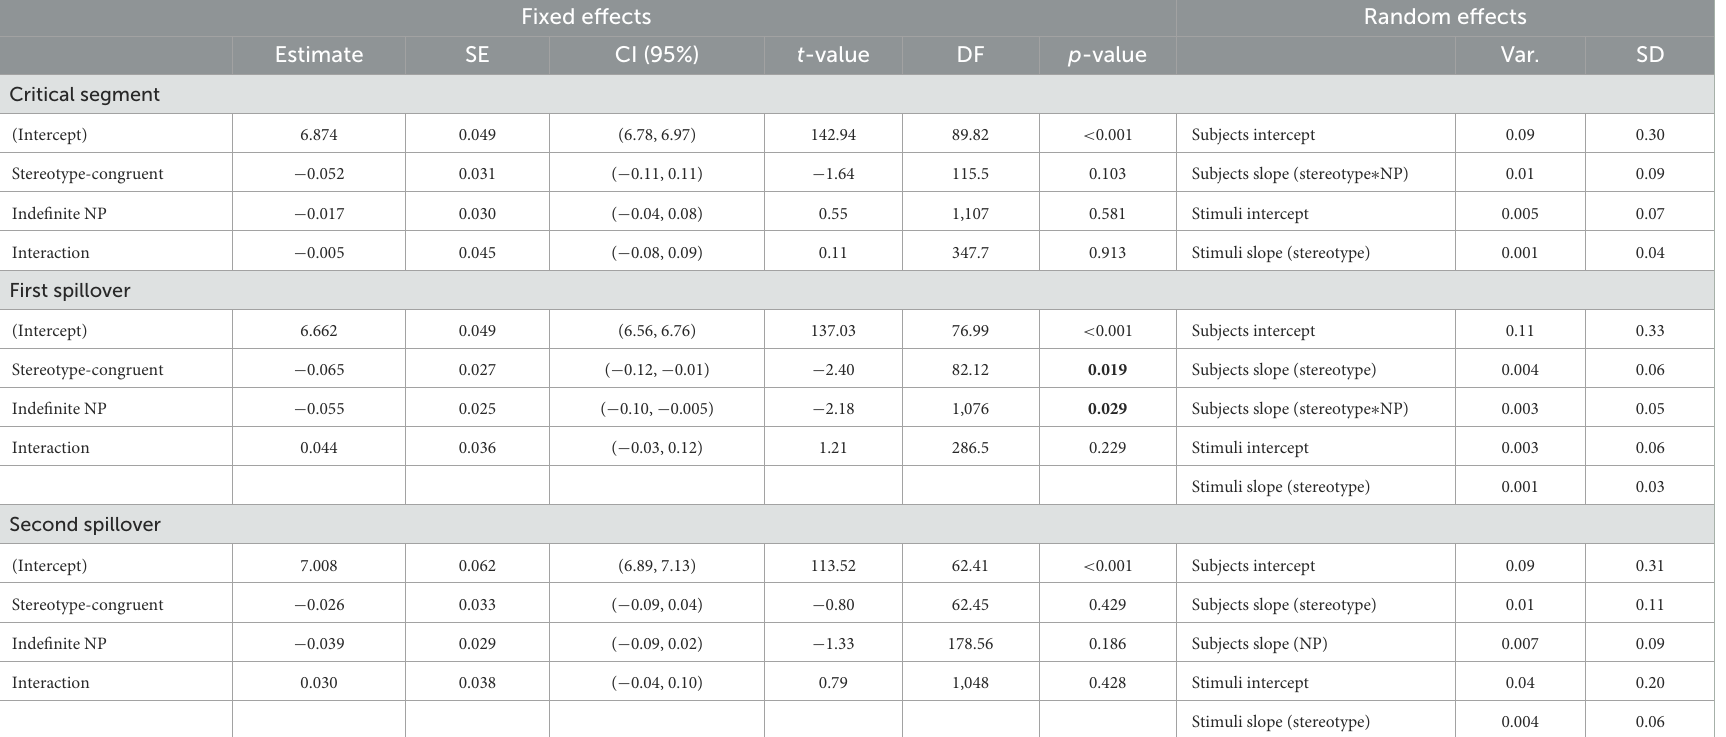
TABLE 4 Statistical results of the selected parsimonious models for Experiment